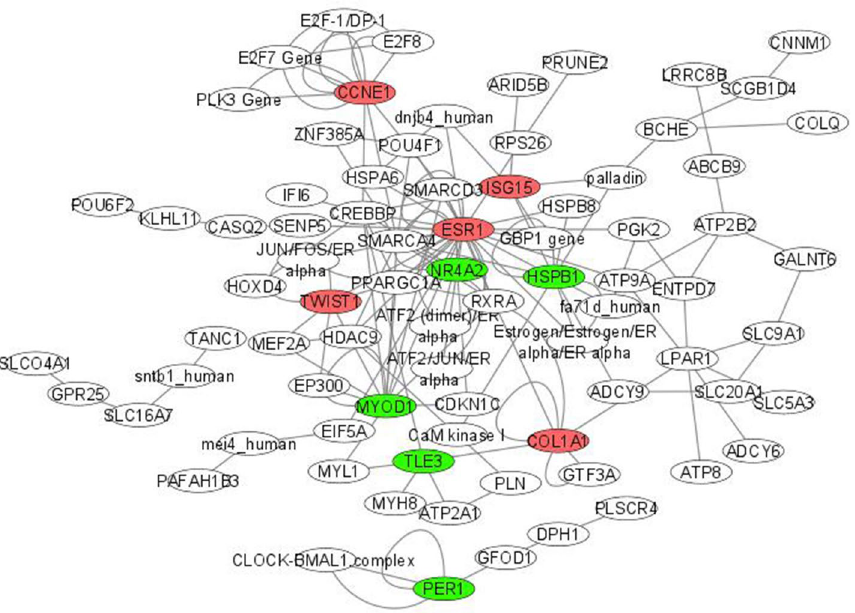
Figure 9. Highly connected differentially expressed genes identified by comparison of age Groups 1 and 4. The top 10 highly connected genes have been highlighted (red: up-regulated; green: down-regulated). Group 1 = 2 tooth stage or 1 years; Group 4 = 8 tooth stage or 3.5–4